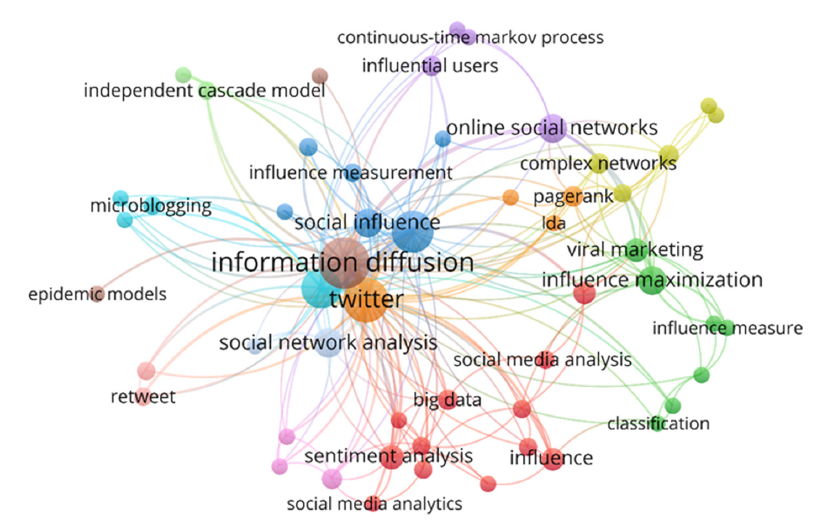
Figure 4. Network visualization of the co-occurrence–word relation for Dataset 1.